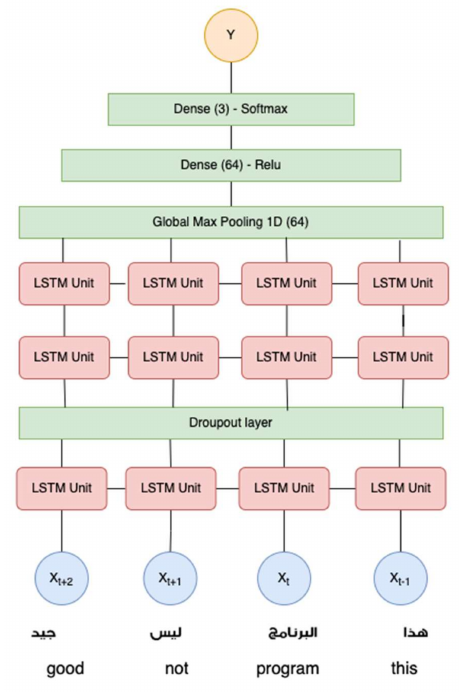
Figure 7. LSTM triple-layer architecture.